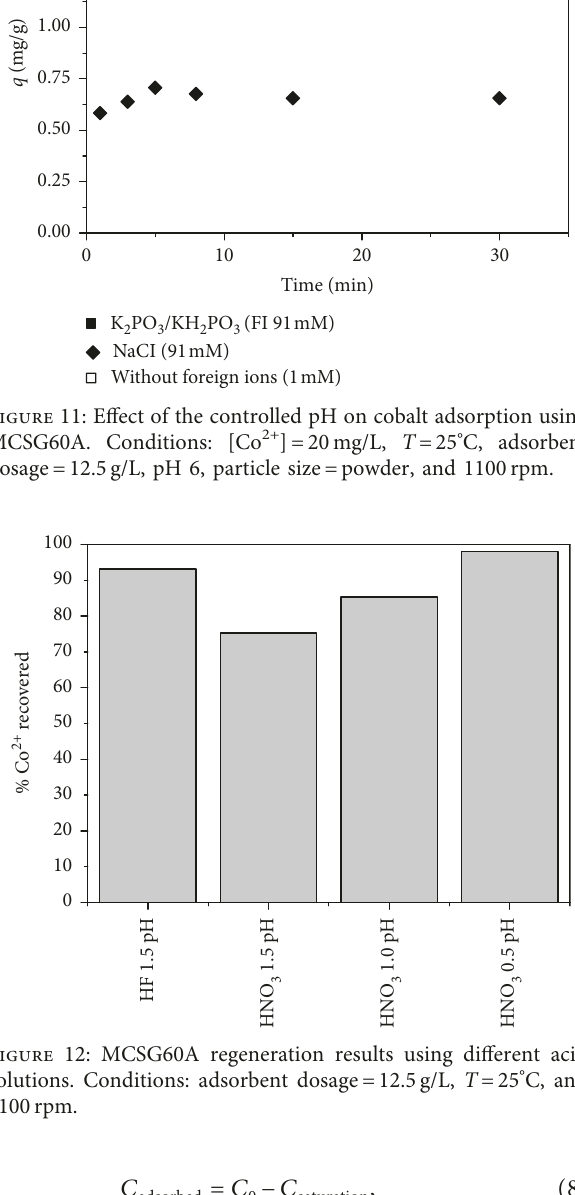
12.5 g/L, T 25 ° C, and (cid:30) (cid:30)